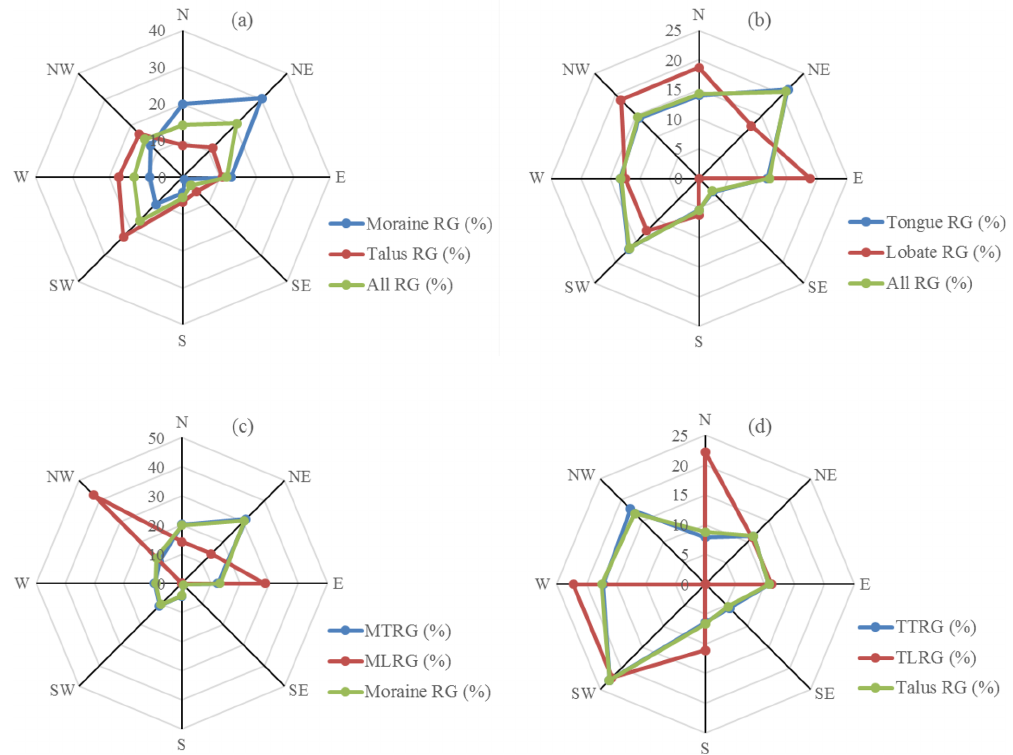
Figure 5. Analysis of the abundances of different rock glacier types vs. aspect. The number of rock glaciers for each aspect on each of the four radar plots is shown as a percentage (%). Note: RG is rock glaciers, MTRG is moraine-type and tongue-shaped rock glaciers, MLRG is moraine-type and lobate rock glaciers, TTRG is talus-derived and tongue-shaped rock glaciers, and TLRG is talus-derived and lobate rock glaciers. Table 3. Correlation matrix of rock glacier variables. Latitude Longitude Altitude Length Width RG area Mean slope Aspect Latitude 1.000 Longitude − 0.893 ∗∗ 1.000 Altitude 0.116* − 0.290 ∗∗ 1.000 Length 0.102 ∗ − 0.062 − 0.075 1.000 Width − 0.020 0.025 0.087 0.063 RG area 0.029 1.000 Mean slope 0.092 − 0.004 − 0.102 ∗ − 0.341 ∗∗ − 0.004 − 0.265 ∗∗ 1.000 Aspect − 0.016 − 0.034 0.045 0.013 − 0.026 0.010 − 0.068